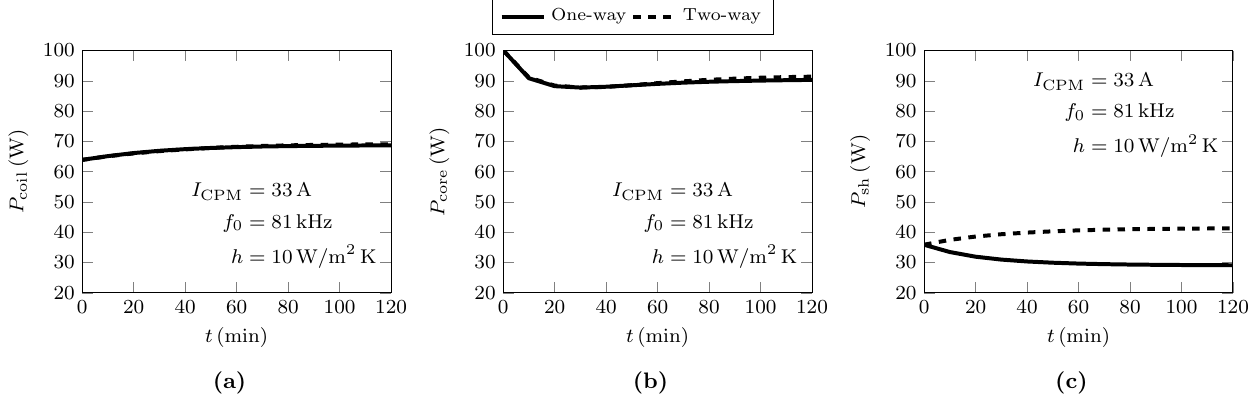
Figure 9. Comparison of the numerically calculated power losses up to an operation time of 120min: ( a ) coil, ( b ) BFM8 ferrites, and ( c ) shielding with heat sinks. The computational time for the one-way coupled simulation was 1 h and 34 min, whereas the two-way coupled simulation required 8 h and 13 min. Both simulations were performed on an AMD Ryzen 3700X 8-core computer with 46 GB of RAM and using equivalent physics and